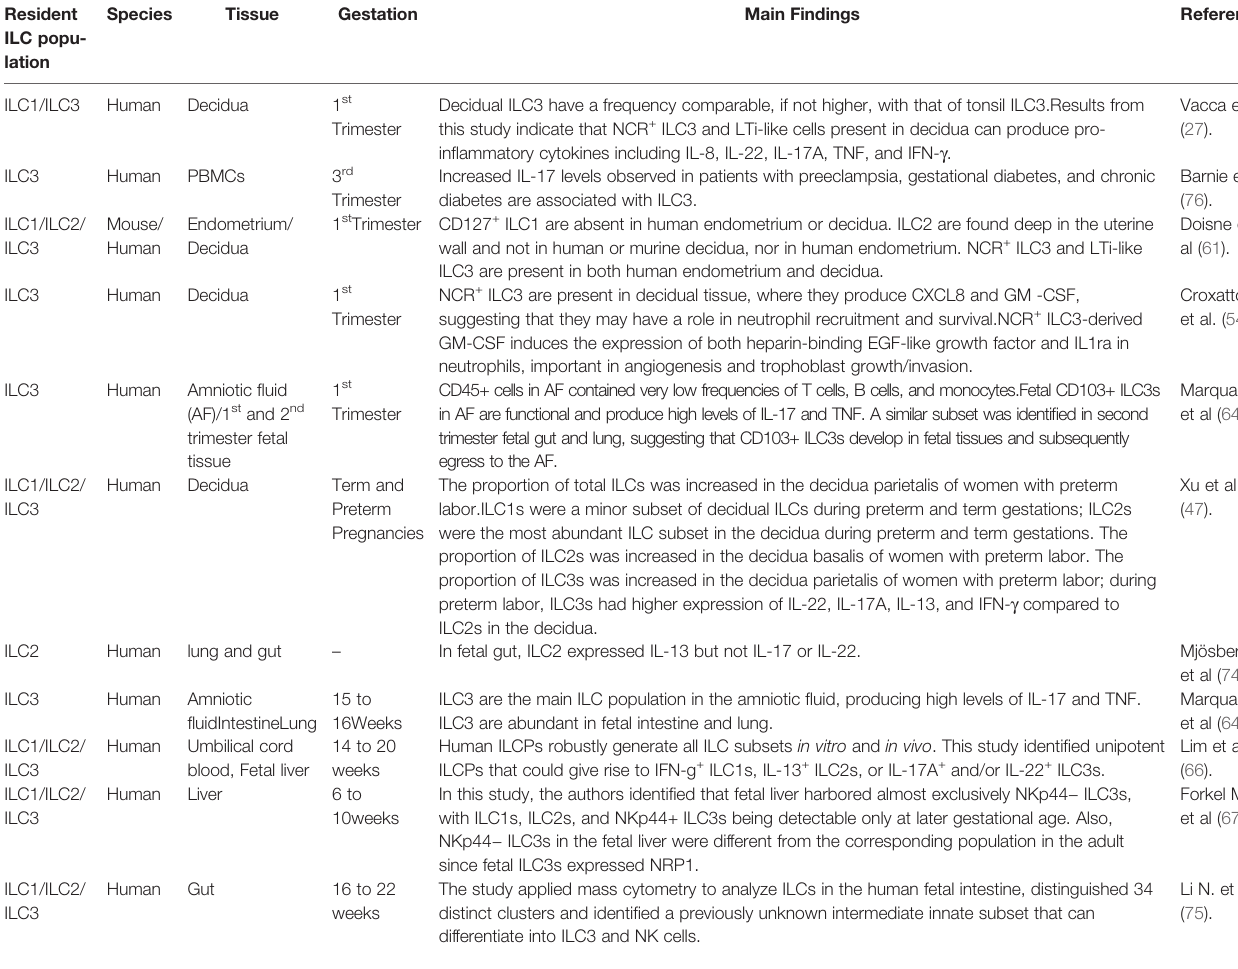
TABLE 1 | Main fi ndings in the literature regarding human ILCs in uterine and fetal